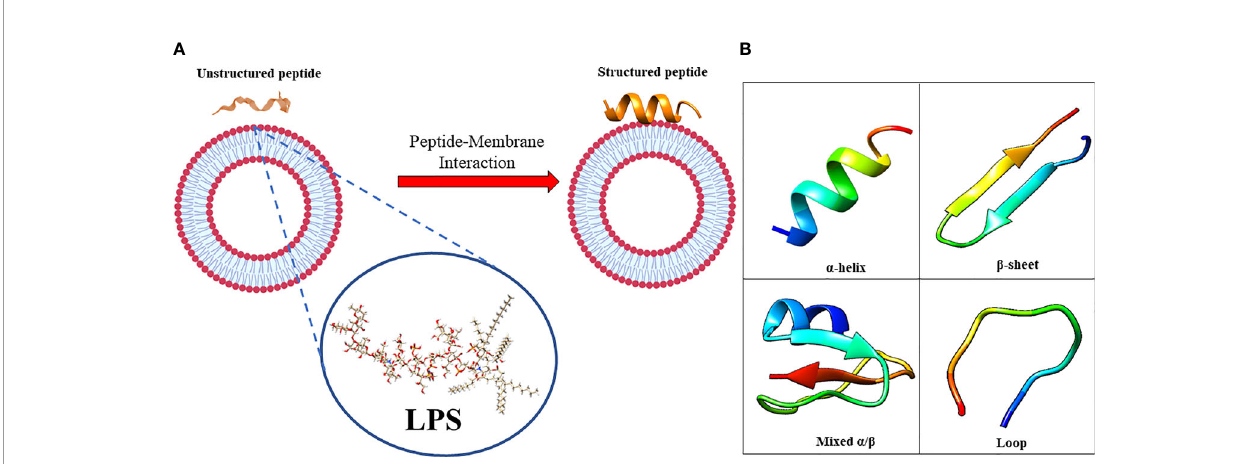
FIGURE 1 | (A) in aqueous solution, the AMPs are unstructured while after the interaction with biological membrane, particularly with the LPS component, they assume the right conformation, which can be (B) a -helical, b -sheet, mixed a -helical/ b -sheet, and loop. Figure created with Biorender.com and UCSF CHIMERA software (Pettersen et al.,